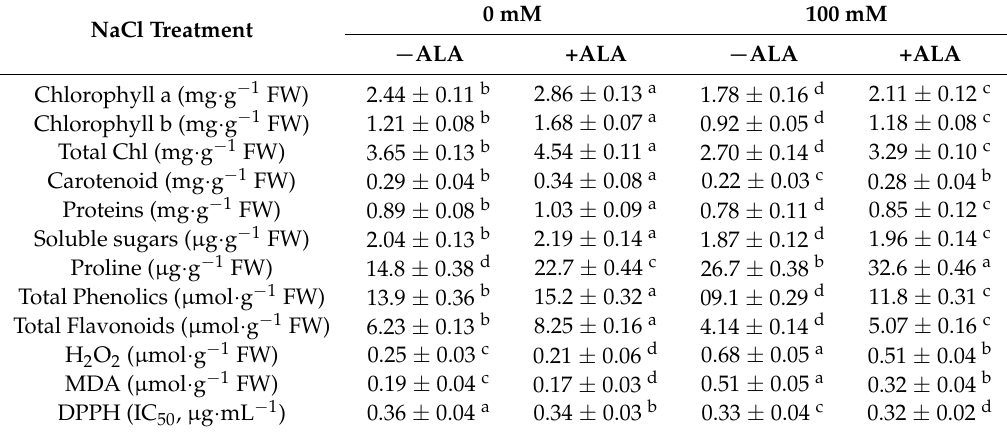
Table 7. Contents of chlorophyll, carotenoids, proteins, sugars, proline, phenolics, flavonoids, H 2 O 2 , MDA and antioxidant activity (DPPH) in leaves of Carmen cultivar under salt and/or ALA (7 ppm)